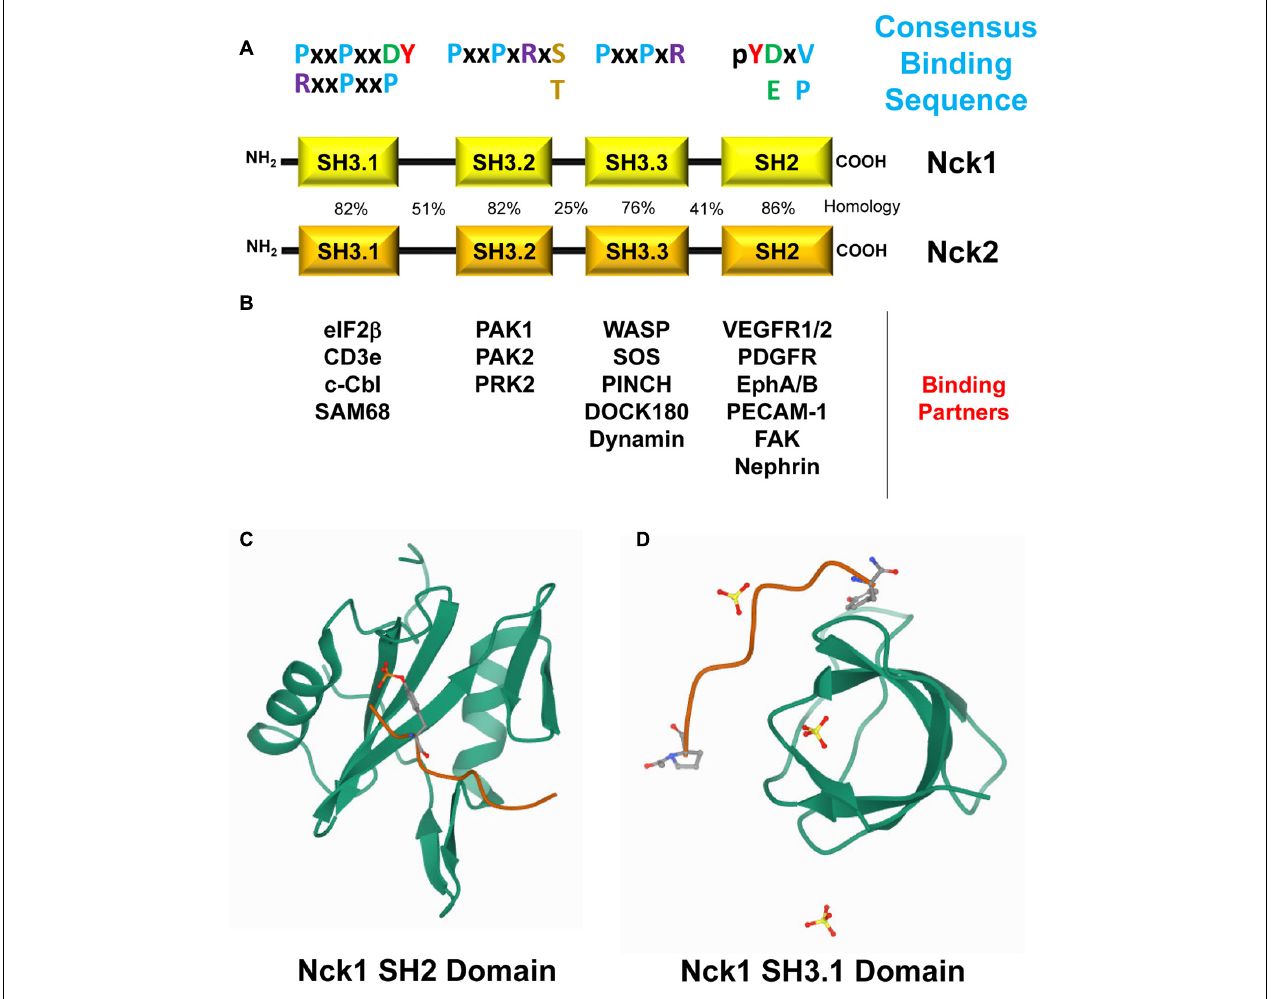
FIGURE 1 | (A) Modular Structure of Nck1 and Nck2 and their binding partners. Nck1 and Nck2 consist of one C-terminal Src-homology domain 2 (SH2) and three N-terminal SH3 domains. The sequence homology in humans (%) of each domain, their consensus binding sequence, and their known binding partners are shown. (B) Selected Nck binding partners and the domains of Nck that mediate these interactions are shown. (C) The Nck1 SH2 domain (PBD ID: 2CI9, RCSB Protein Data Bank, https://www.rcsb.org/) complexed with a phosphotyrosine peptide (Frese et al., 2006). (D) The Nck1 SH3.1 domain (PBD ID: 5QU2, RCSB Protein Data Bank, https://www.rcsb.org/) complexed with a PPPVPNPDY peptide (Richter et al.,